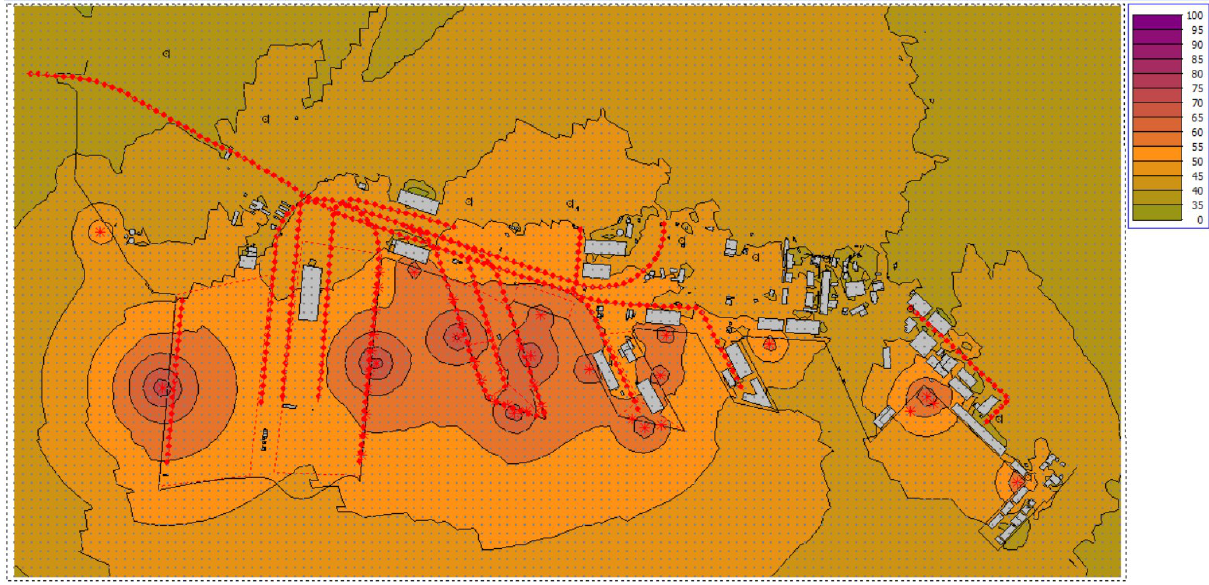
Figure 7: Noise map of the Port of Thessaloniki for the most common wind conditions (Lnight)